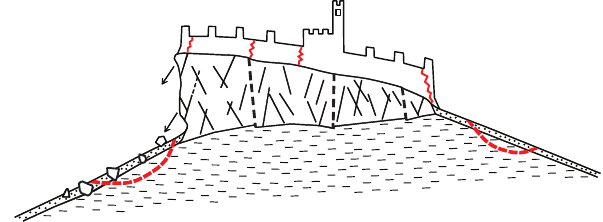
Fig. 1. Simplified sketch of the instability mechanisms affecting a rock slab overlying a soft